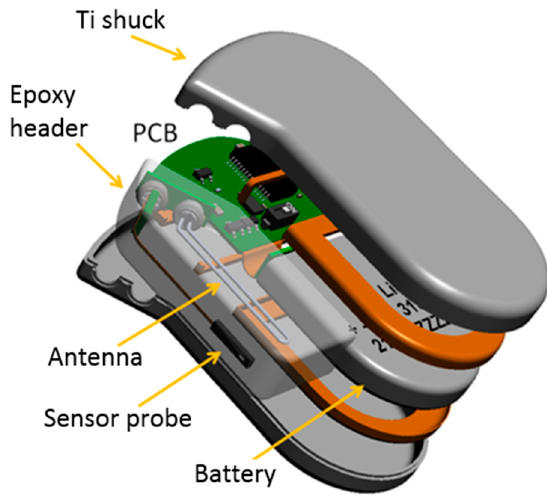
Figure 3. Explosion scheme of biosensor implant in a Ti/epoxy housing.